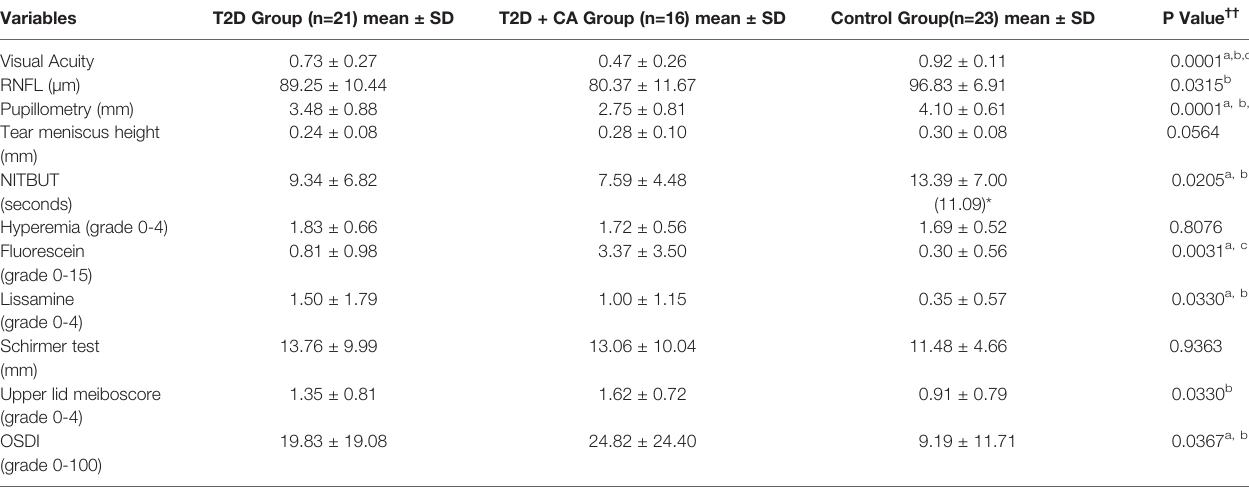
TABLE 3 | Comparisons in ocular variables between type 2 diabetes (T2D) patients with Charcot arthropathy (CA), T2D patients without CA, and healthy individuals.